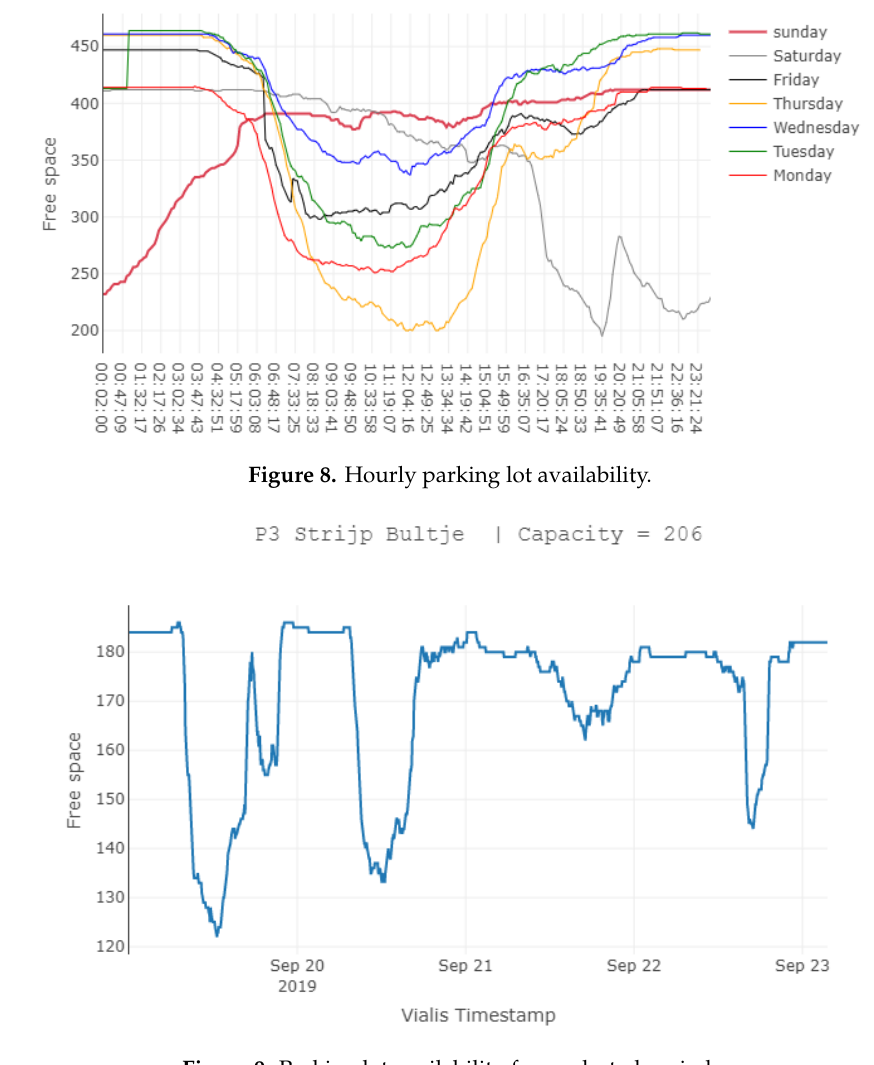
Figure 9. Parking lot availability for a selected period.